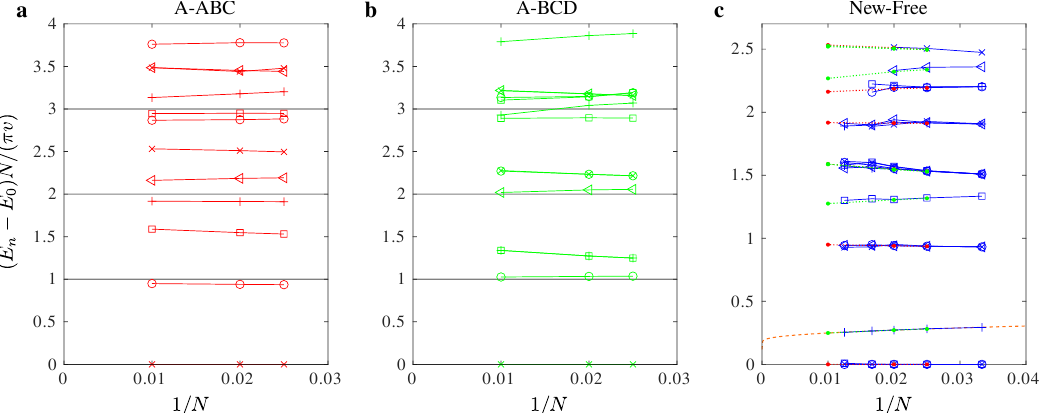
Figure 6: Conformal towers of states of the four-state Potts model with a-b fixed boundary condition on one edge and three-state-mixed boundary conditions on the other edge, and with c transverse-polarized (New) boundary condition on one edge, while the second edge is free. Symbols are DMRG data points extracted from the low- lying energy excitation spectra with velocity v = π/ 4. Gray lines are integer levels shown for reference. In c the results from a (dotted red) and b (dotted green) are shown as a reference, the latter is shifted such that it starts at the first excites state of the New-Free tower. Each level in New-Free tower that matches a level of the A- ABC tower is three-fold degenerate. Orange dashed line is a finite-size extrapolation assuming log-corrections in the form derived by Cardy [ 45 ]